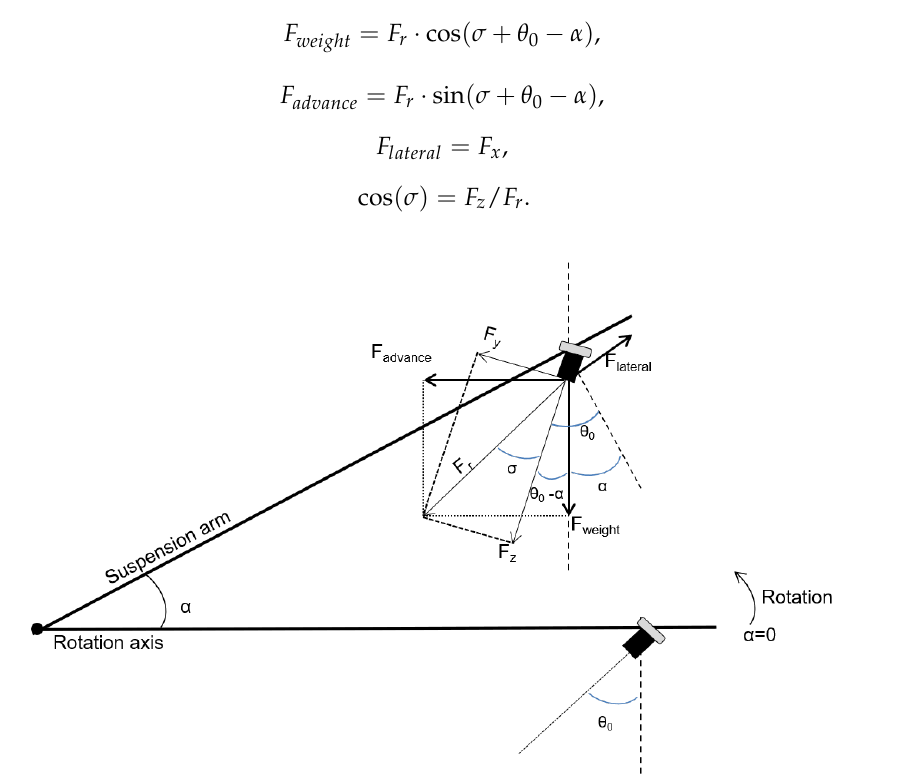
Figure 10. Force component extraction from the sensor